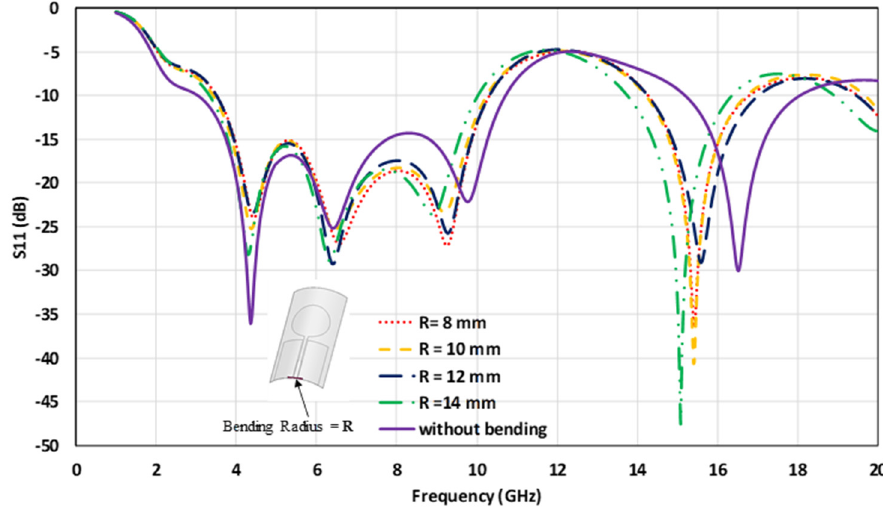
Figure 12. The simulated bending impact on the antenna’s return loss.